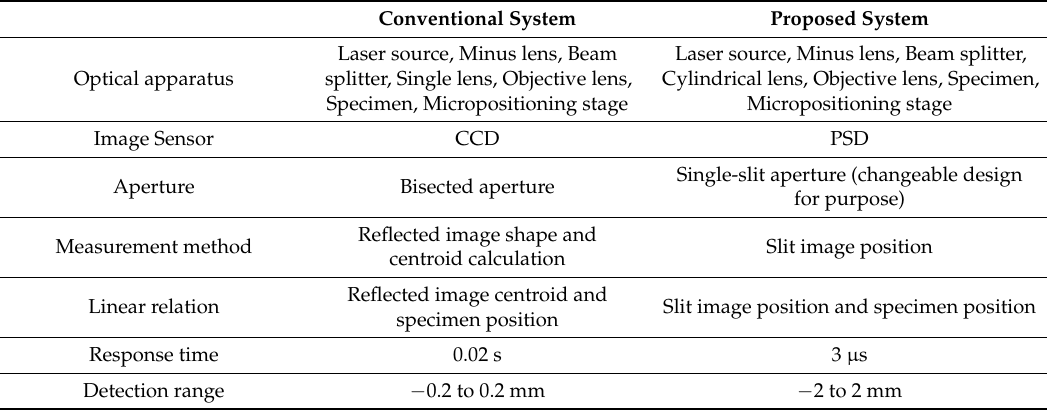
Table 1. Comparison between the conventional and proposed focus inspection